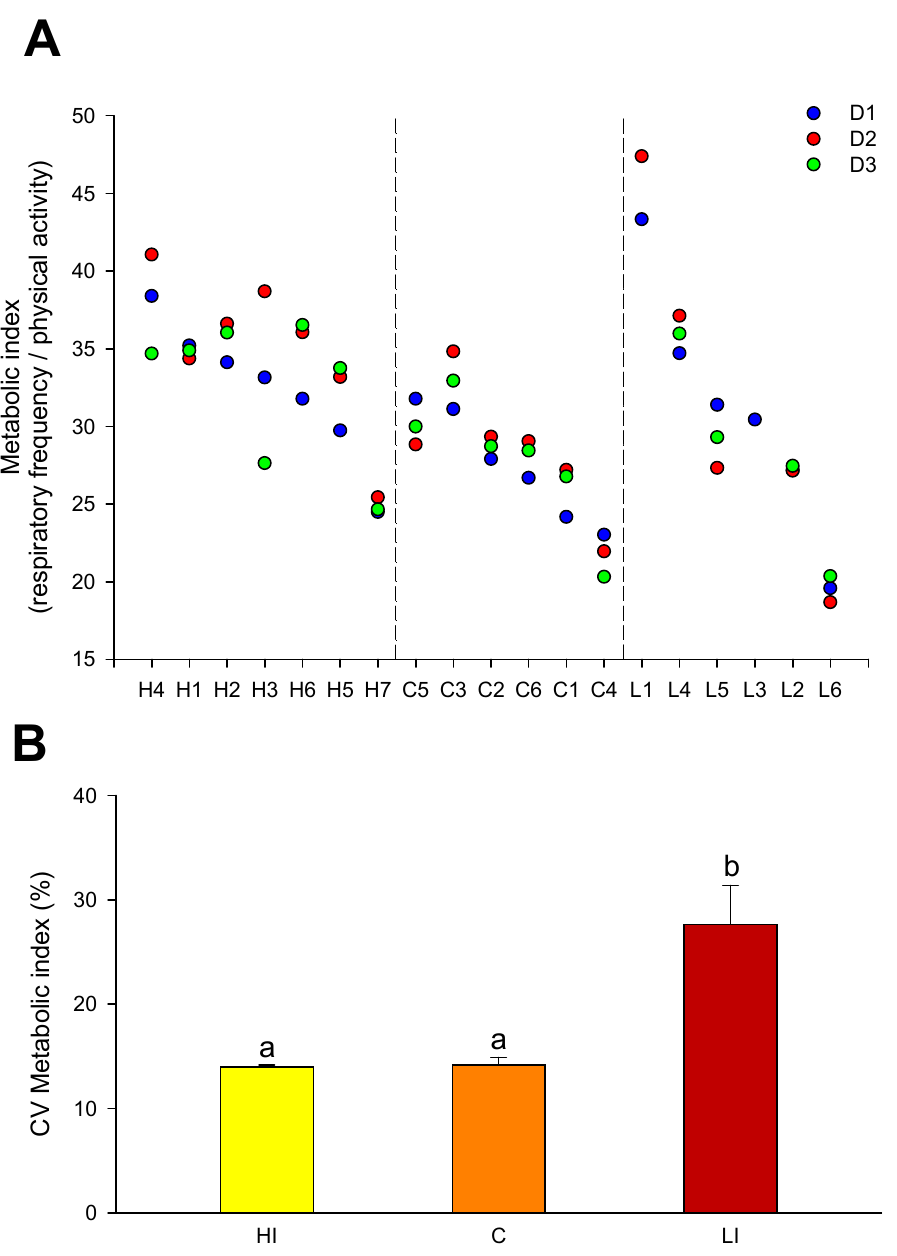
Figure 5. ( A ) Daily metabolic index (respiratory frequency/physical activity) in each individual during three days of exposure to different light intensities (D1–D3): HI, C, and LI. For each individual, the metabolic indexes of D1 (blue circles), D2 (red circles), and D3 (green circles) are represented. ( B ) Coefficient of variation (CV) of the metabolic index of fish exposed to different light intensities: HI (yellow bars), C (orange bars), and LI (red bars). Each value is the mean ± SEM of the daily coefficient of variation of 6–7 individuals for three days. Different letters indicate significant differences ( p < 0.01, one-way ANOVA).